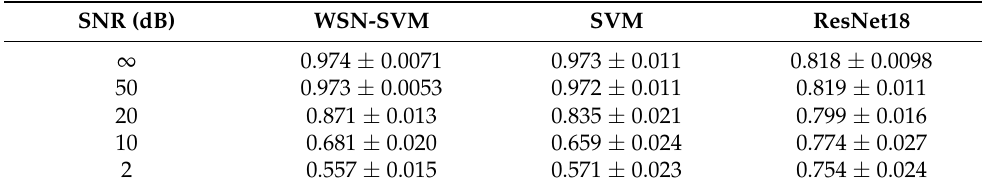
Table 3. Performance accuracies of non-quantized WSNs, SVMs, and